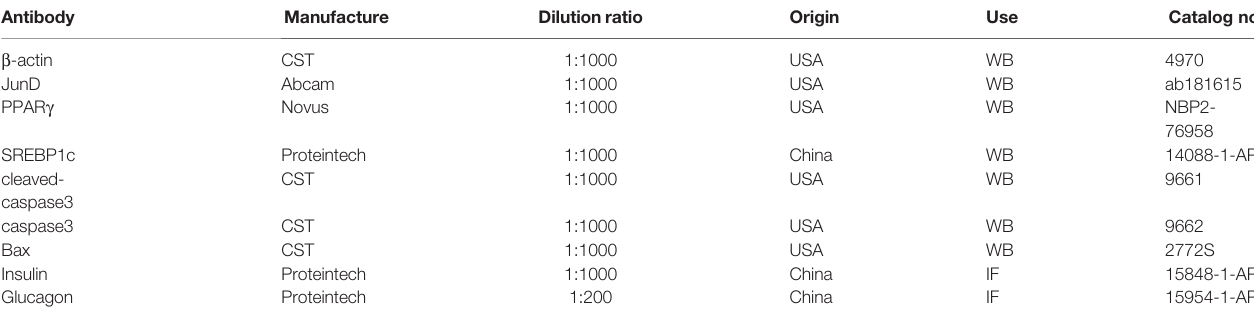
TABLE 1 | Antibodies used in this study.